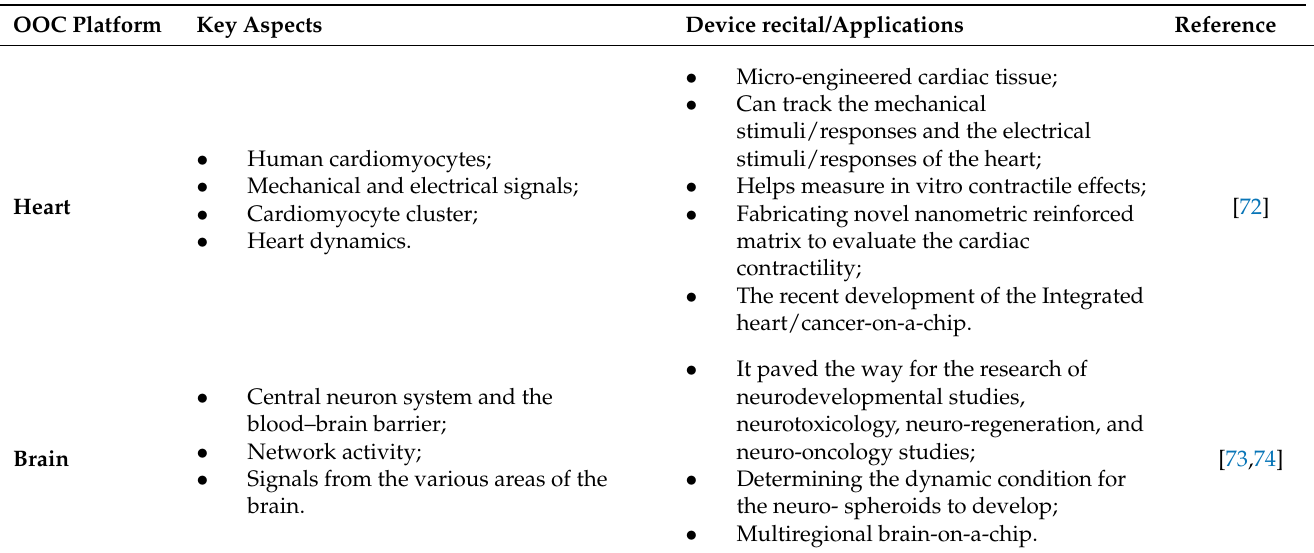
Table 2. OOC different platforms: Salient traits and chip performances (Adapted from [71], slightly